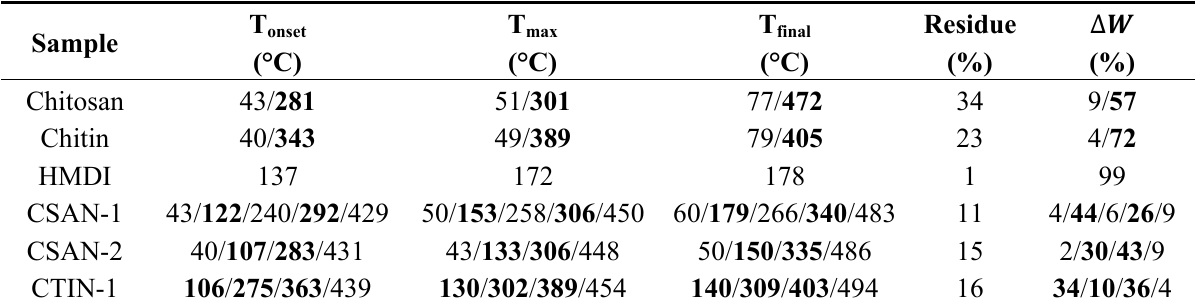
Table 2. TGA characteristic parameters for the biodegradable thickeners studied and starting